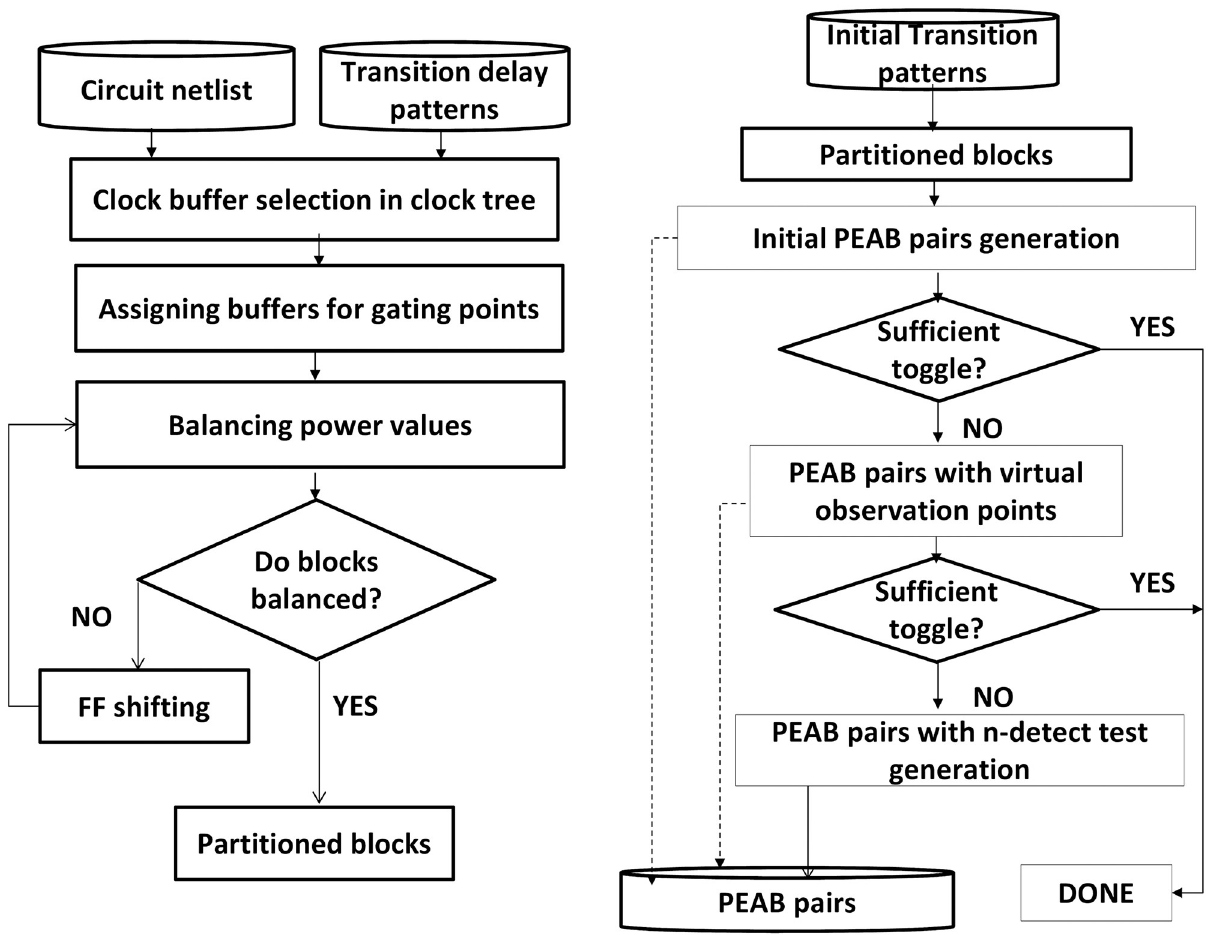
Fig 3. Flowchart representation of the proposed PEAB pair generation. The clock-tree partitioning algorithm selects gating points in the clock-tree in a top-down tree traversal fashion. The clock tree with the number of clock nodes or buffers and the num- ber of blocks are given as inputs. The function recursively determines gating points from the root of the clock tree. If the number of leaf nodes is less than a given number of blocks, the pro- cess assigns gating points to all the leaf nodes. If there are more leaf nodes, the number of chil- dren nodes are assigned to gating points based on their mean dynamic power values. Since the transient power when applying a pattern consists of dynamic power from an activated block and leakage power from an entire circuit, partitioning affects only dynamic powers. If the number of required blocks is greater or equal to the number of clock nodes, the algo- rithm distributes gating points to the children according to their dynamic power values. Alter- natively, if two or more gating points are assigned to one child, the algorithm recursively assigns gating points to a sub-clock tree rooted by the child. If the number of required blocks is less than the number of clock nodes, the algorithm selects children nodes using a bin-pack- ing algorithm. Fig 4 displays that seven clock gating points are selected from the 23 clock nodes. Nodes N12 and N13 combine to a single node by a bin-packing algorithm. The red-col- ored circular nodes are selected as gating points in the clock tree.